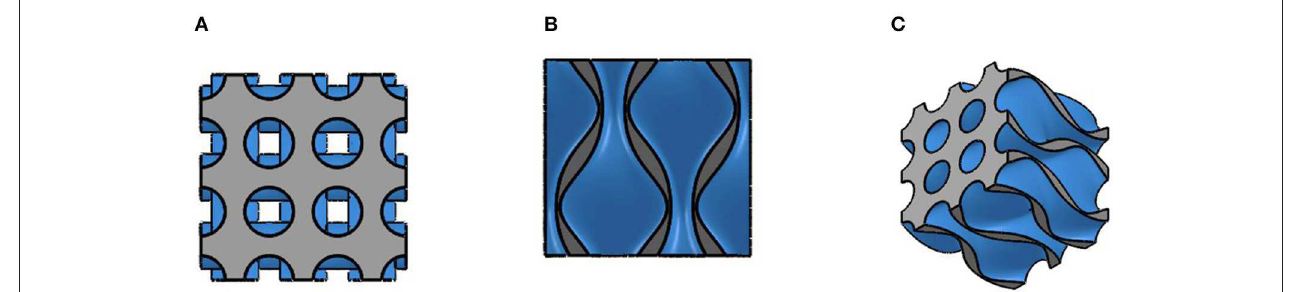
FIGURE 5 | (A) A differential volume of the zoomed-in top/bottom view of the AMR with the double corrugated flow pattern. (B) A differential volume of a zoomed-in side view of AMR with the double corrugated flow pattern. (C) A differential volume of a zoomed-in isometric view of AMR with the double corrugated flow pattern. The solid material is displayed by gray color and flow channels are displayed by blue color. The video with animated rotation of the differential volume is available at Supplementary Video 1